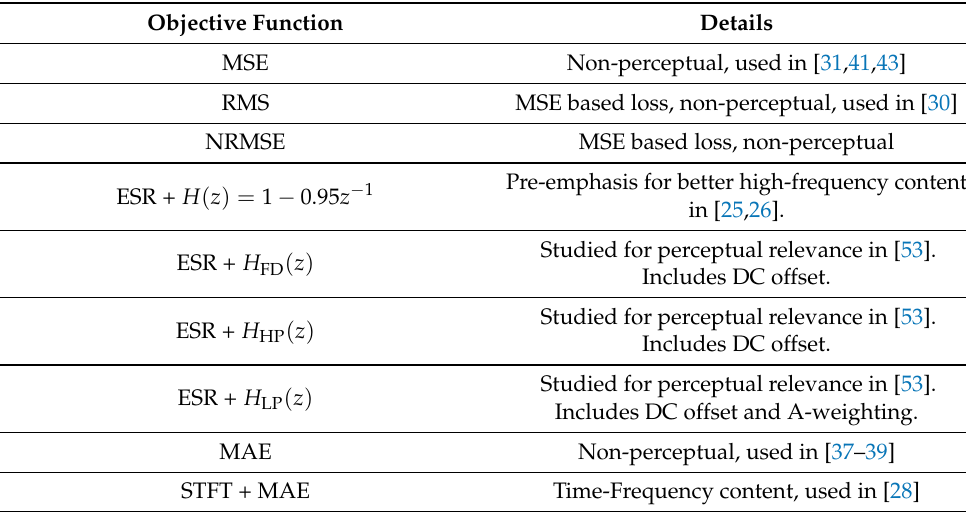
Table 5. Summary of the loss functions and their perceptual